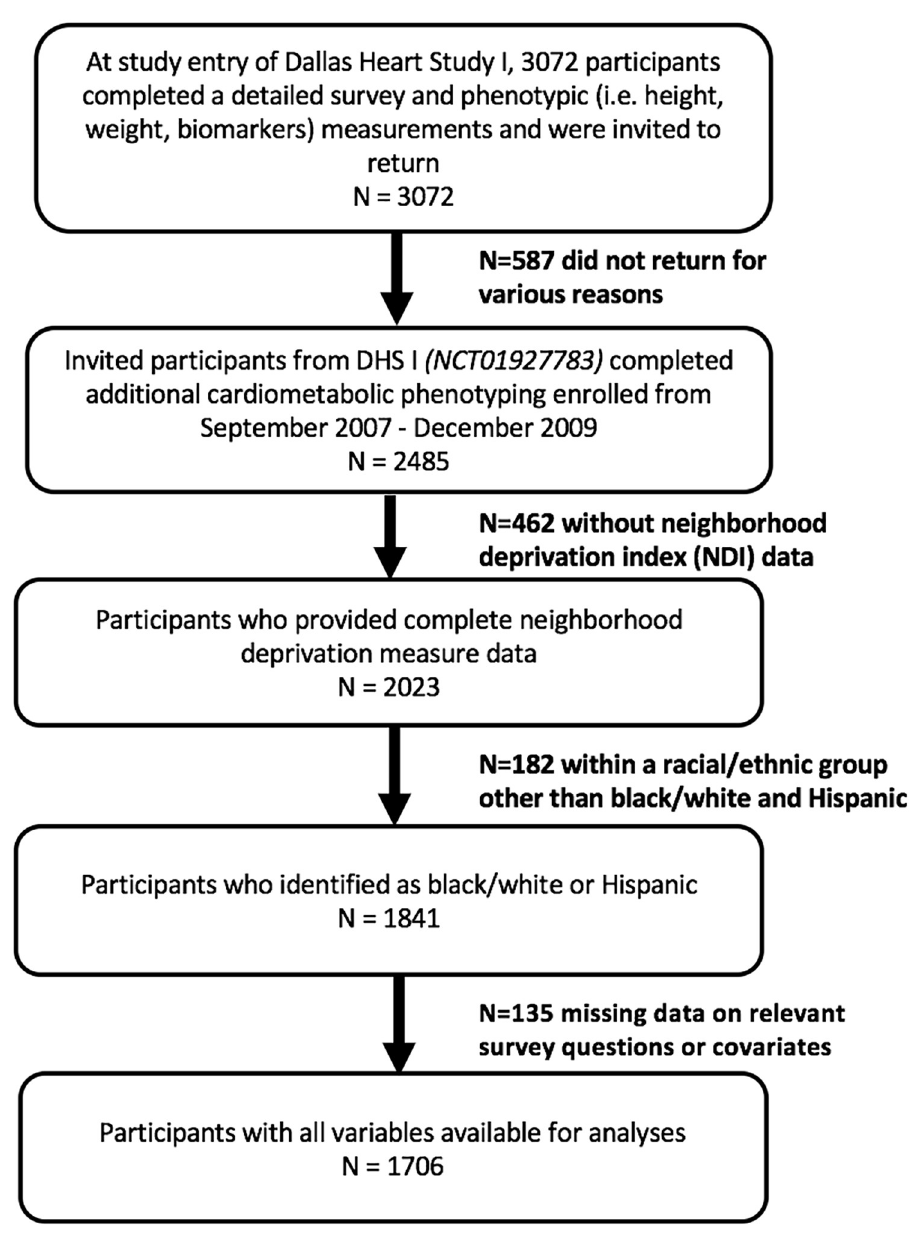
Fig 2. CONSORT diagram describing analytic